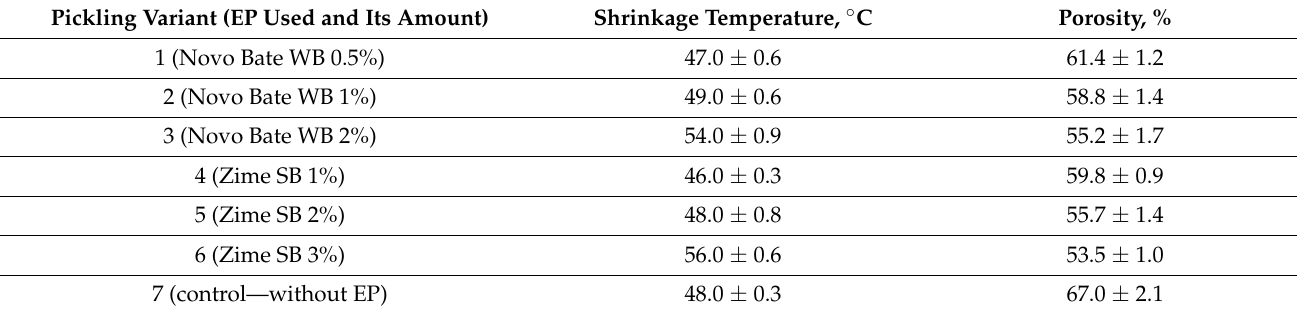
Table 1. Influence of enzyme preparation addition on pickled pelt properties.